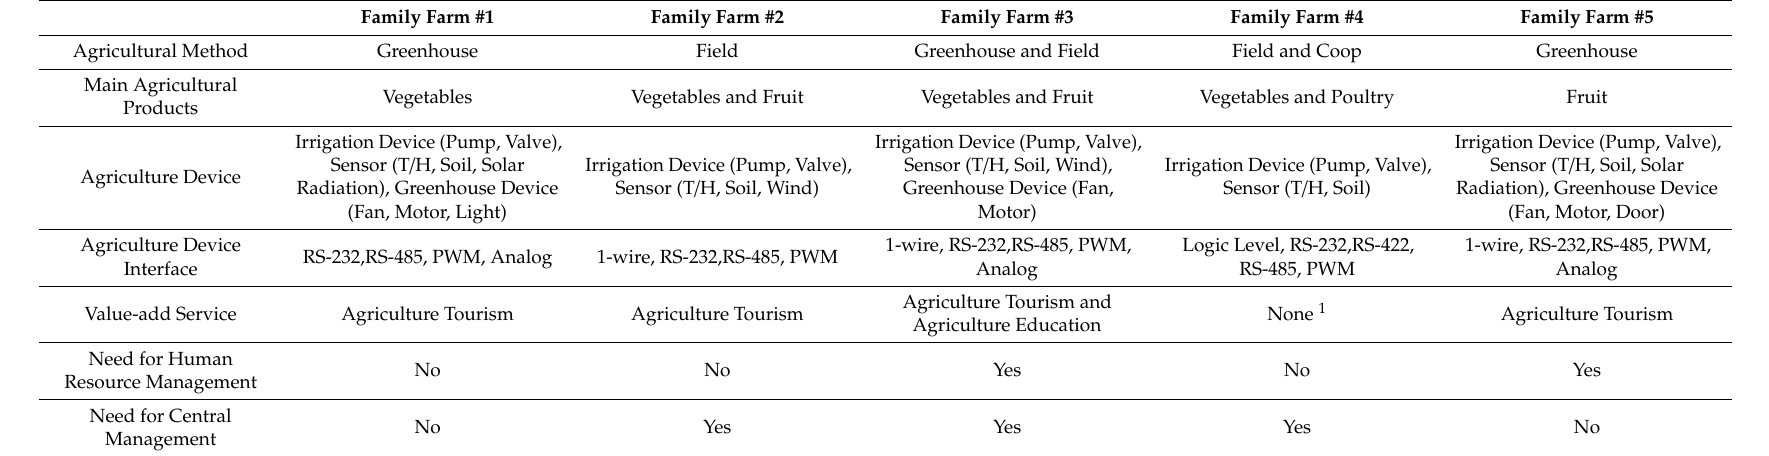
Table 1. The characteristics and business in the family farms.